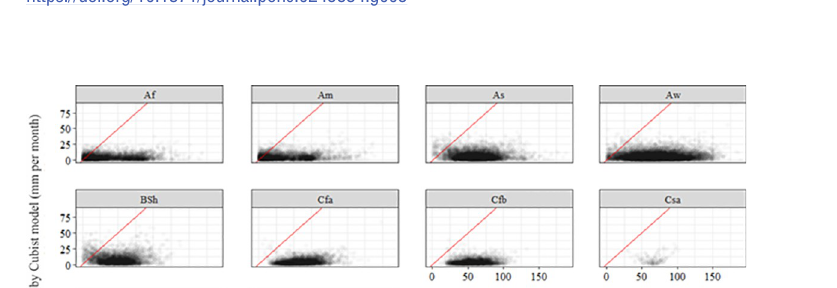
Fig 5. Box plot of the residuals observed in the MOD16 PET product and the ETo modeled by Cubist.